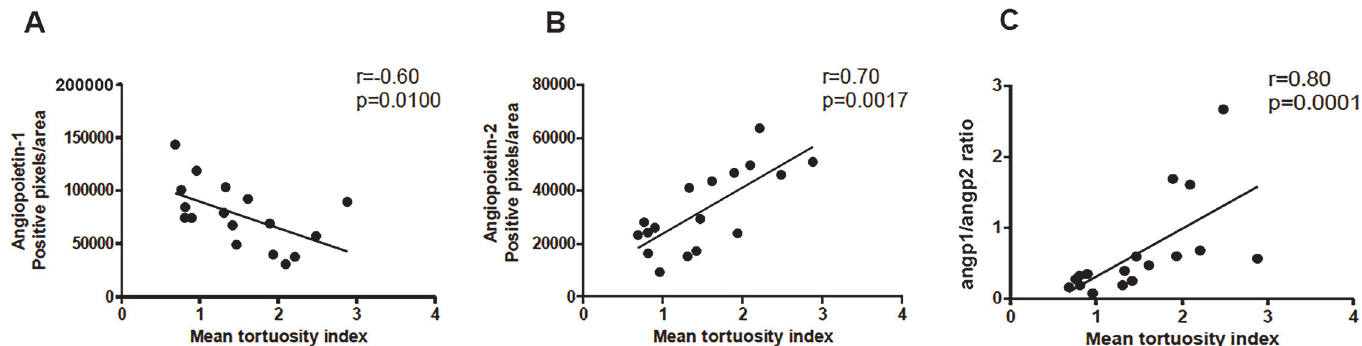
Fig 5. Correlation between capillary tortuosity and Angpt2/Angpt1balance and creatinine levels. Scatter plot showing the correlation of renal protein expression of Angpt1(A), Angpt2 (B), Angpt2/Angpt1ratio